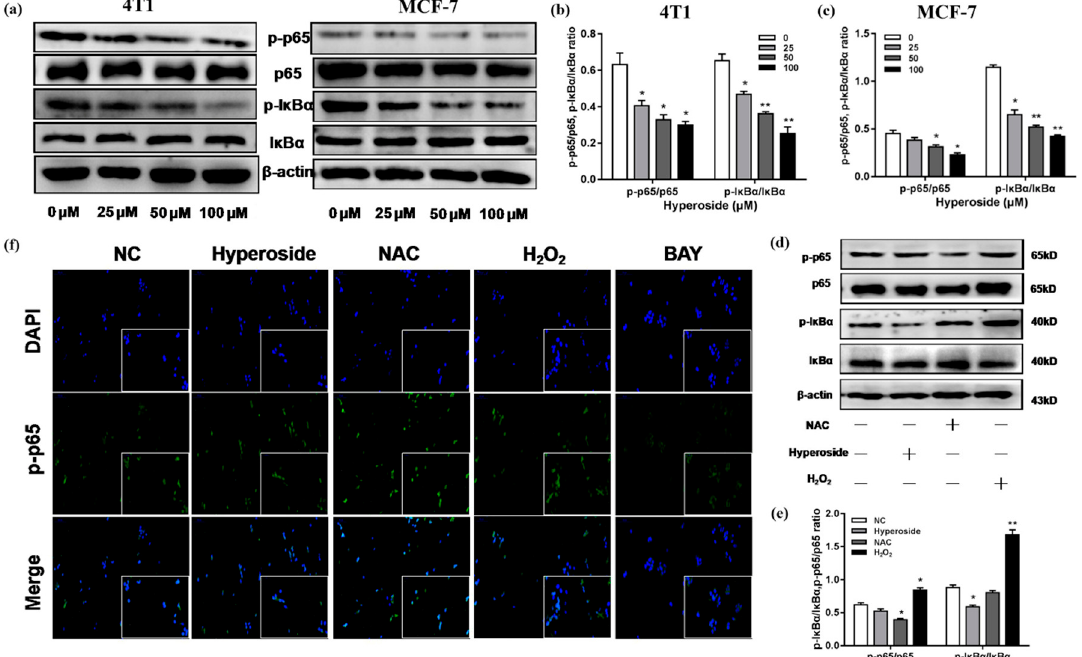
Figure 4. Hyperoside inhibits the NF- κ B signaling pathway via ROS. MCF-7cells and 4T1 cells were stimulated with hyperoside (25, 50 and 100 µ M), NAC (10 mM), H 2 O 2 (25 µ M), and hyperoside (50 µ M) for 24 h, respectively. ( a – e ) Western blot was used to determine the proteins level of p65, p-p65, I κ B- α , and p-I κ B- α . β -actin was used for normalization. ( f ) Immunofluorescence images hyperoside and NAC inhibited p-p65 activation in 4T1 cells. Data are expressed as mean ± SD of three independent experiments. * p < 0.05, ** p < 0.01 (Student’s t -test).